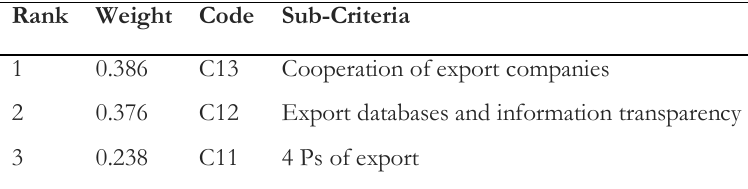
Table 5. Weight and rank of export marketing sub-criteria.